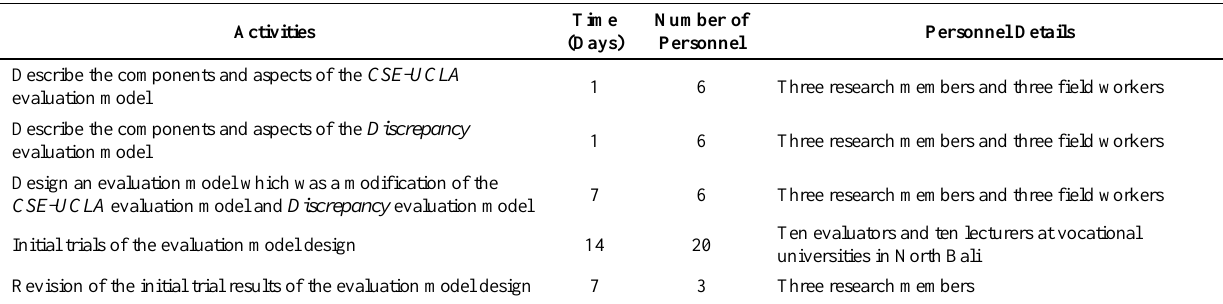
Table 3. Data of the Completion Planning for the Design that Modification Results of the CSE-UCLA Model and the Discrepancy Model.